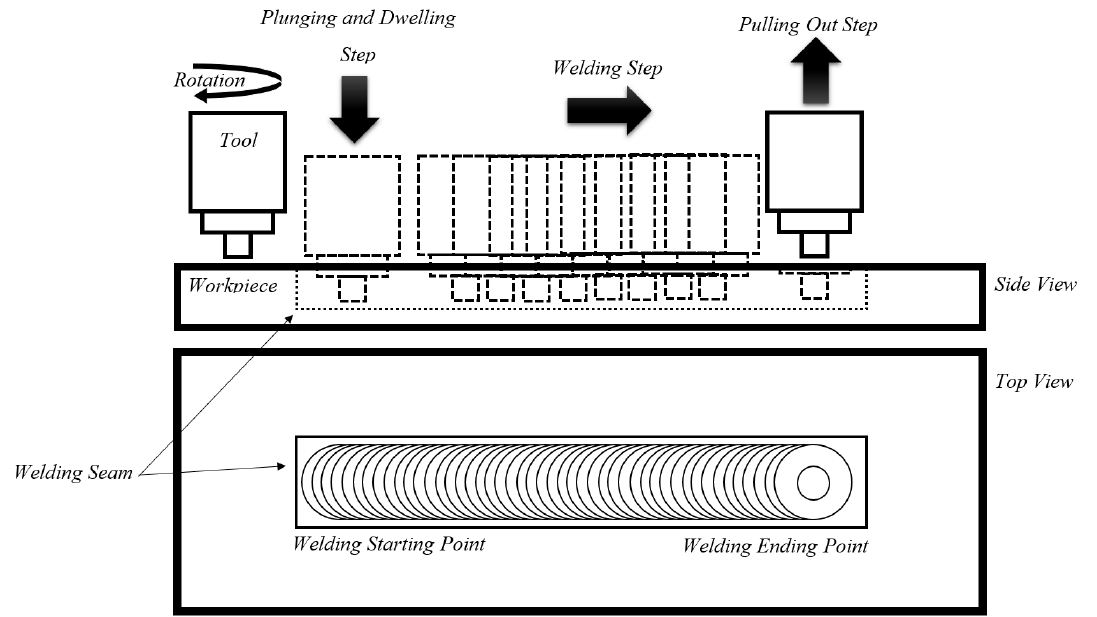
Figure 1. The principle of the FSW process.